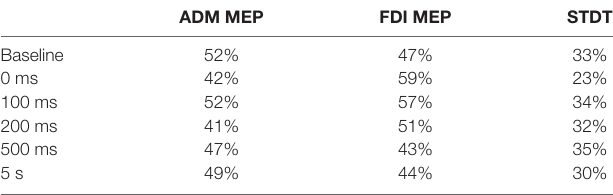
(STDT) intersubject coefficient of variation (COV) at baseline and 0 ms, 100 ms, 200 ms, 500 ms and 5 s. The COV was calculated as the ratio of the standard deviation to the mean and was expressed as a